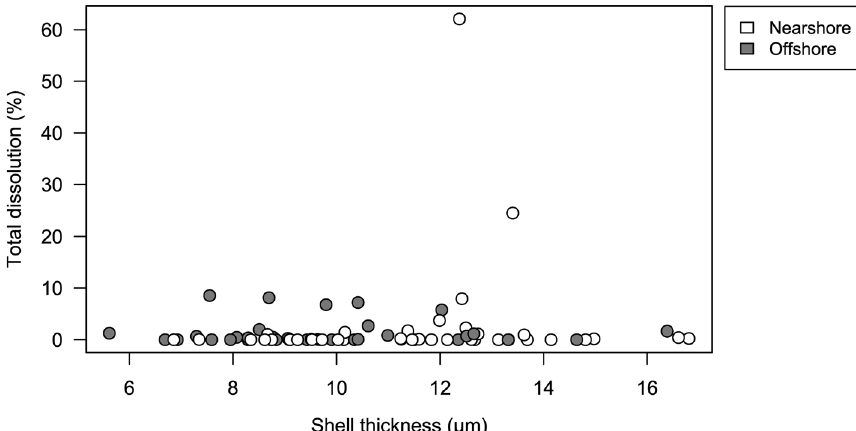
Figure 5. Percentage surface area with dissolution marks (%) and average shell thickness of the individual shells. Each dot represents an individual pteropod shell analyzed for both average shell thickness and dissolution marks. Circles indicate individuals from nearshore stations with strong upwelling conditions (grey), and offshore stations with less intense upwelling conditions (white). See Fig. 4 for examples of dissolution marks, Fig. S5 for specific graphs of the three different dissolution types, and Fig. S8 for an illustration of the calculation